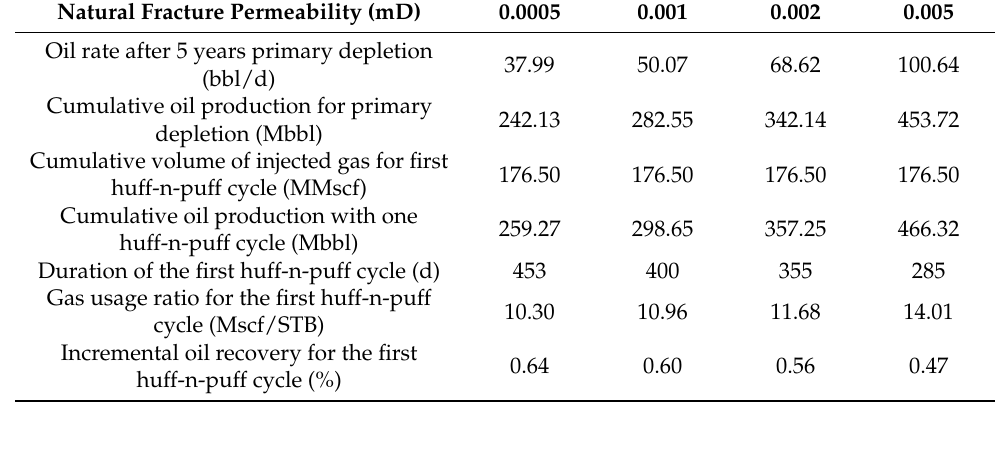
Table 12. Summary of results for huff-n-puff with different natural fracture permeability.